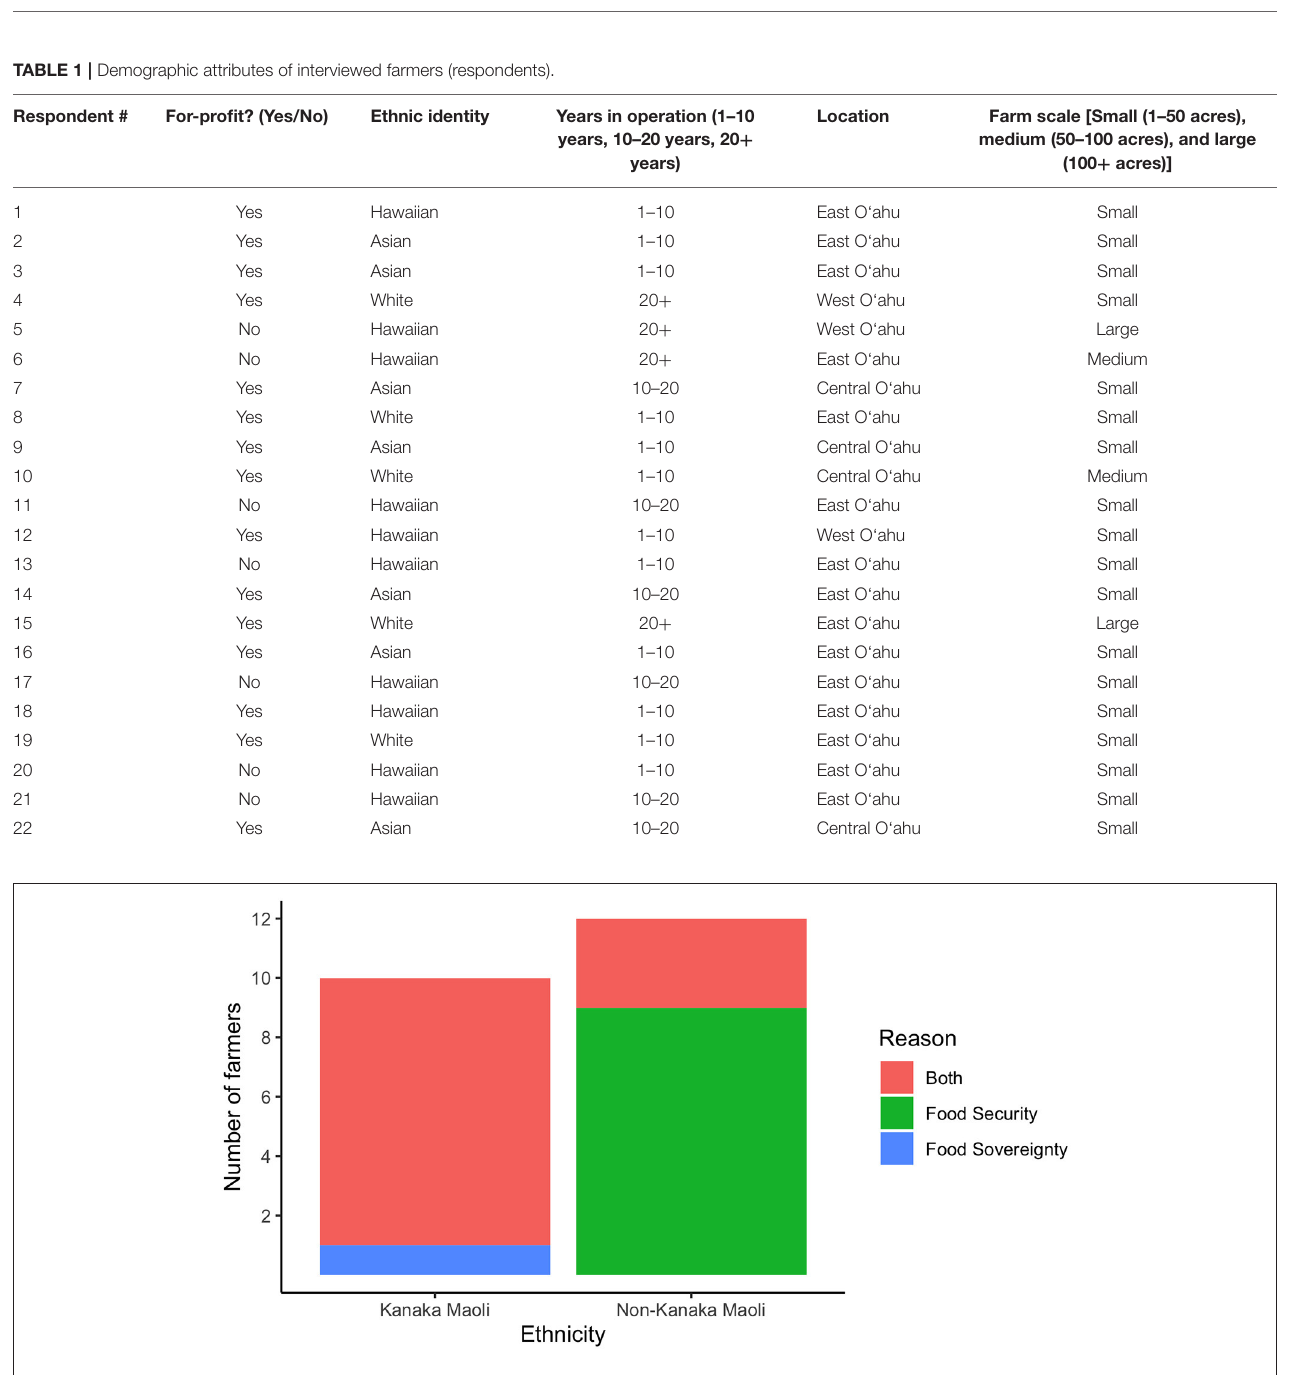
FIGURE 1 | Number of respondents who selected food secuirty, food sovereignty, or both as a reason they began and continue